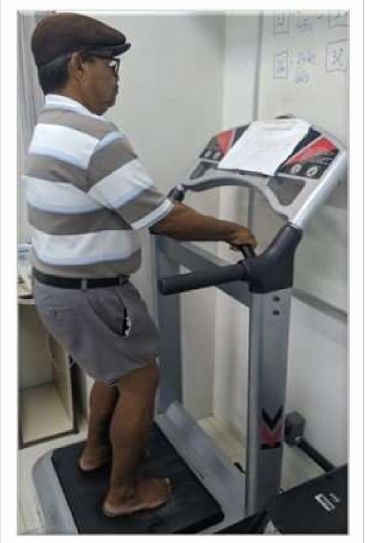
Figure 2. Participant position during vibration